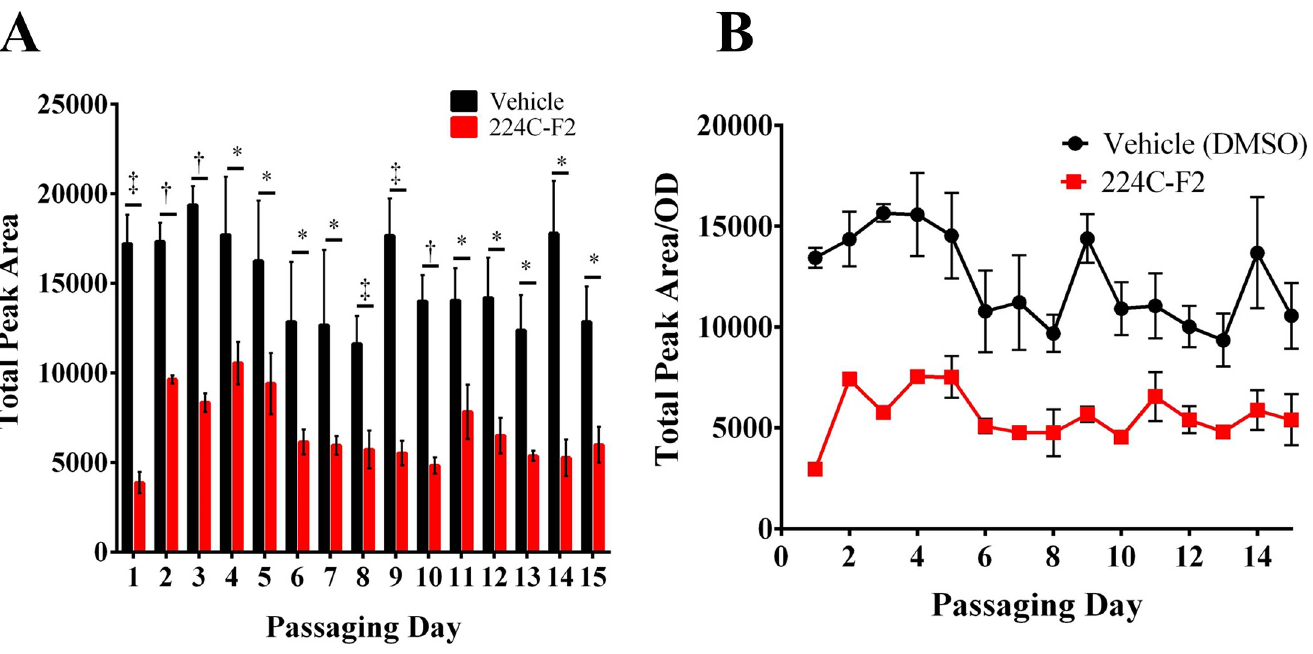
Fig 6. 224C-F2 attenuates virulence without any detectable resistance after 15 days of drug passaging. Cultures of USA500 isolate NRS385 ( agr group I) were passaged for 15 consecutive days in the presence of 16 μ g mL -1 of 224C-F2. (A) The sum total peak area of de-formylated and formylated delta toxin was quantified for the mock vehicle control (DMSO) and treated group. A significant difference (p < 0.05) was evident for all treatment days. (B) 224C-F2 inhibited delta-toxin production over the length of the passaging experiment in the absence of growth inhibition. Significant differences between treatment and vehicle are represented as: * : p < 0.05; ‡ : p < 0.01; † : p <